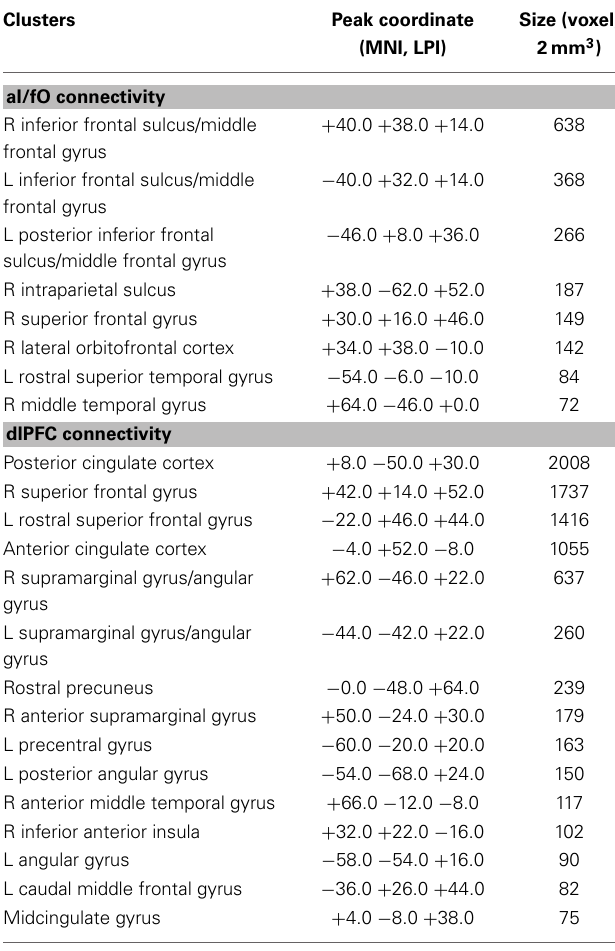
Table 2 | Clusters showing increased connectivity after L dlPFC